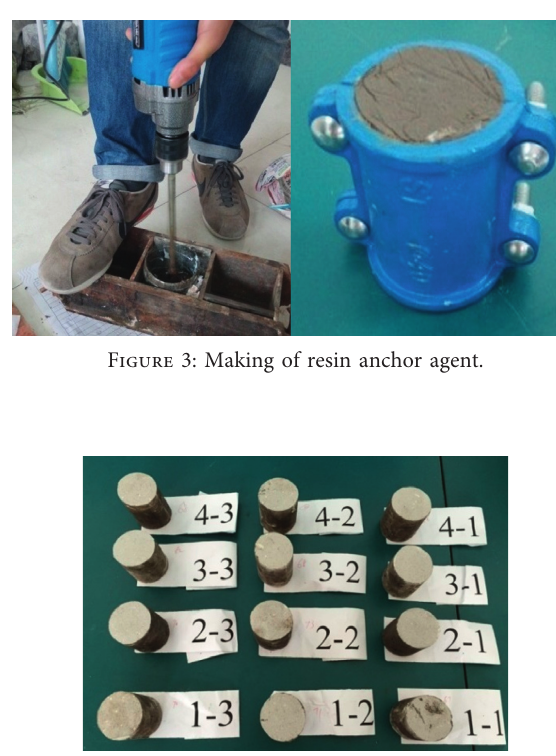
Figure 4: Resin anchor agent test specimens.